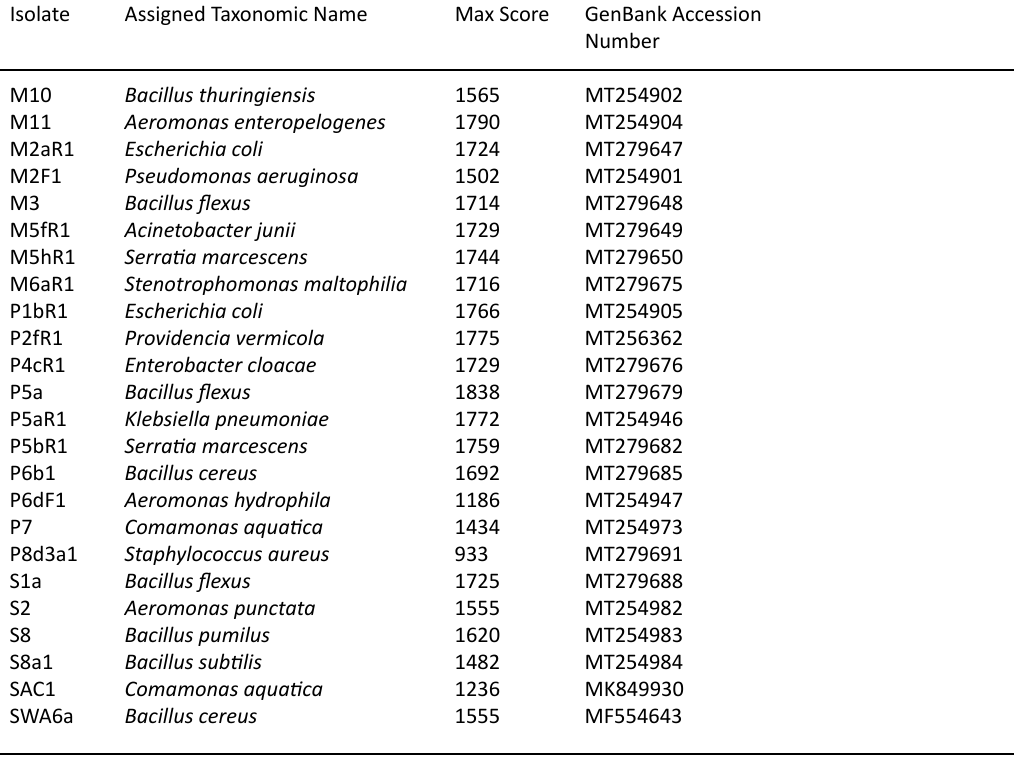
Table 3. The assigned taxonomic name and Max Score of the twenty-four bacterial strains along with GenBank accession numbers